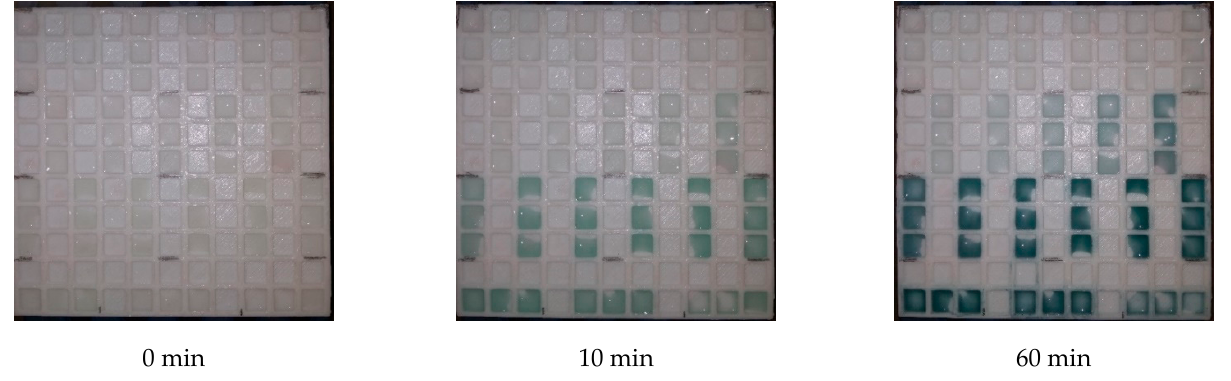
Figure 9. Illustrative photographs showing 42 of the total 121 wells with solutions of 40 µL butyrylcholinesterase (BChE) (0–100 µkat/mL). The measuring pad was photographed in the beginning of experiment, after 10 min and after 60 min.